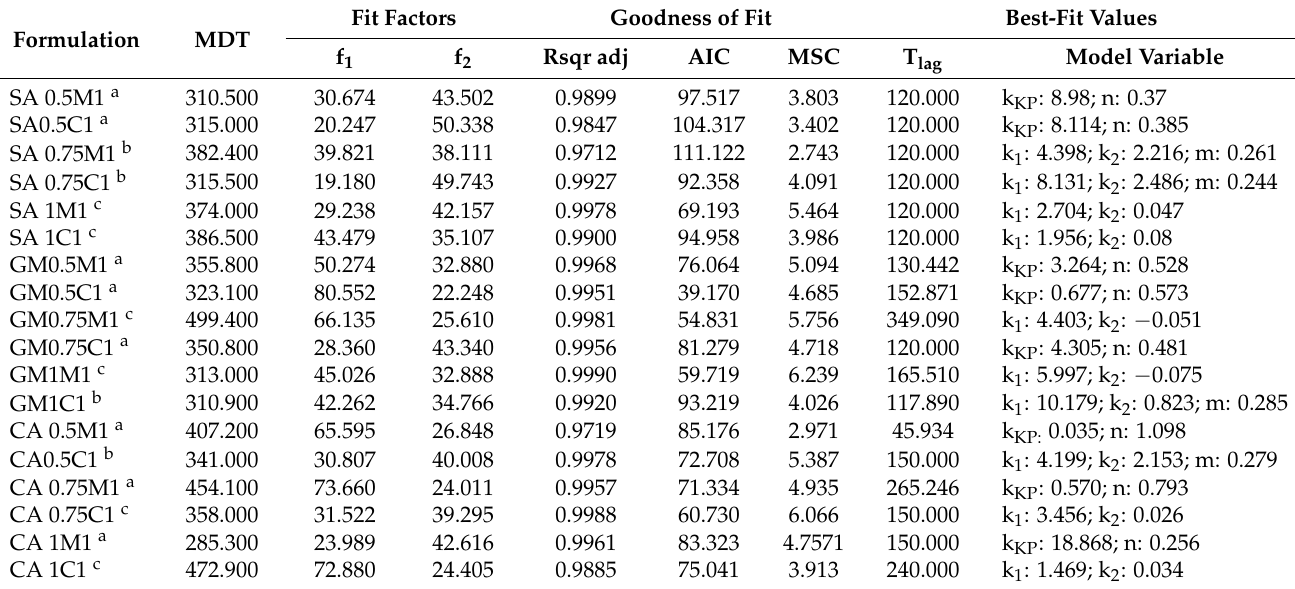
Table 4. Release kinetics of artemether from lipid matrix tablets in sequential dissolution media, including biorelevant components, according to different mathematical models and fit factor values versus the release kinetics of Coartem ® . Formulation